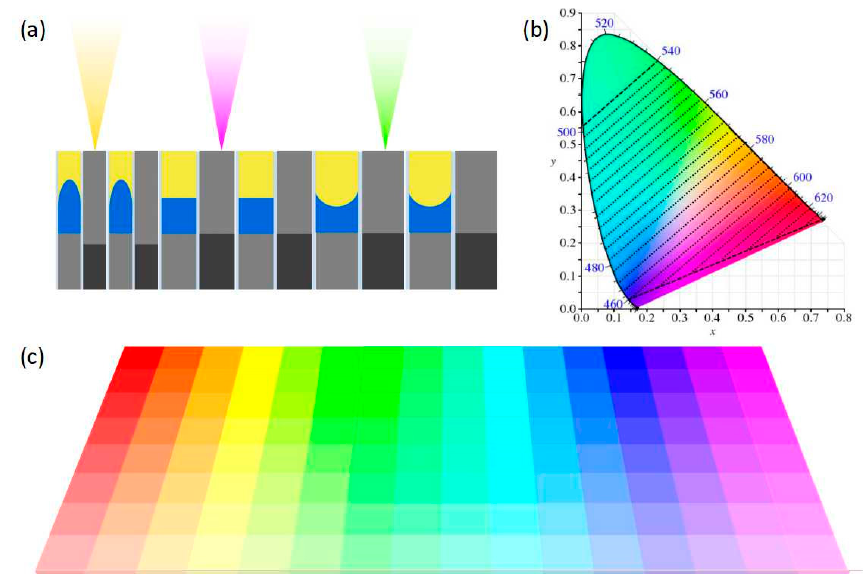
Figure 4. ( a ) The schematic diagram of the proposed integrated filtering device based on the grating structure. The periods of the three parts are 250 nm, 400 nm and 550 nm, respectively. ( b ) The range of gamuts that the filtering device can produce in CIE 1931 xy chromaticity coordinates (dashed line). ( c ) Color gradient map that can be achieved by selecting the appropriate parameters.